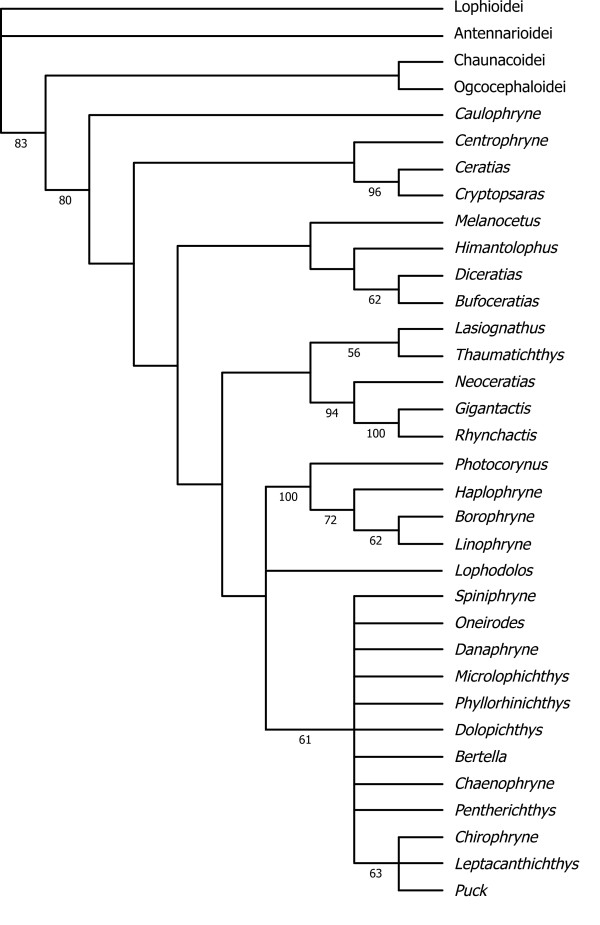
A strict consensus of the 11 most parsimonious tree derived from maximum parsimony (MP) analysis of 53 morphological characters. These morphological characters are applicable to the metamorphosed females only (71 characters used in Pietsch and Orr [33] minus 18 characters that are supposedly show reductive or simplified states; for details see text). The 11 MP trees had a total length of 100, a consistency index of 0.610, and a retention index of 0.835.